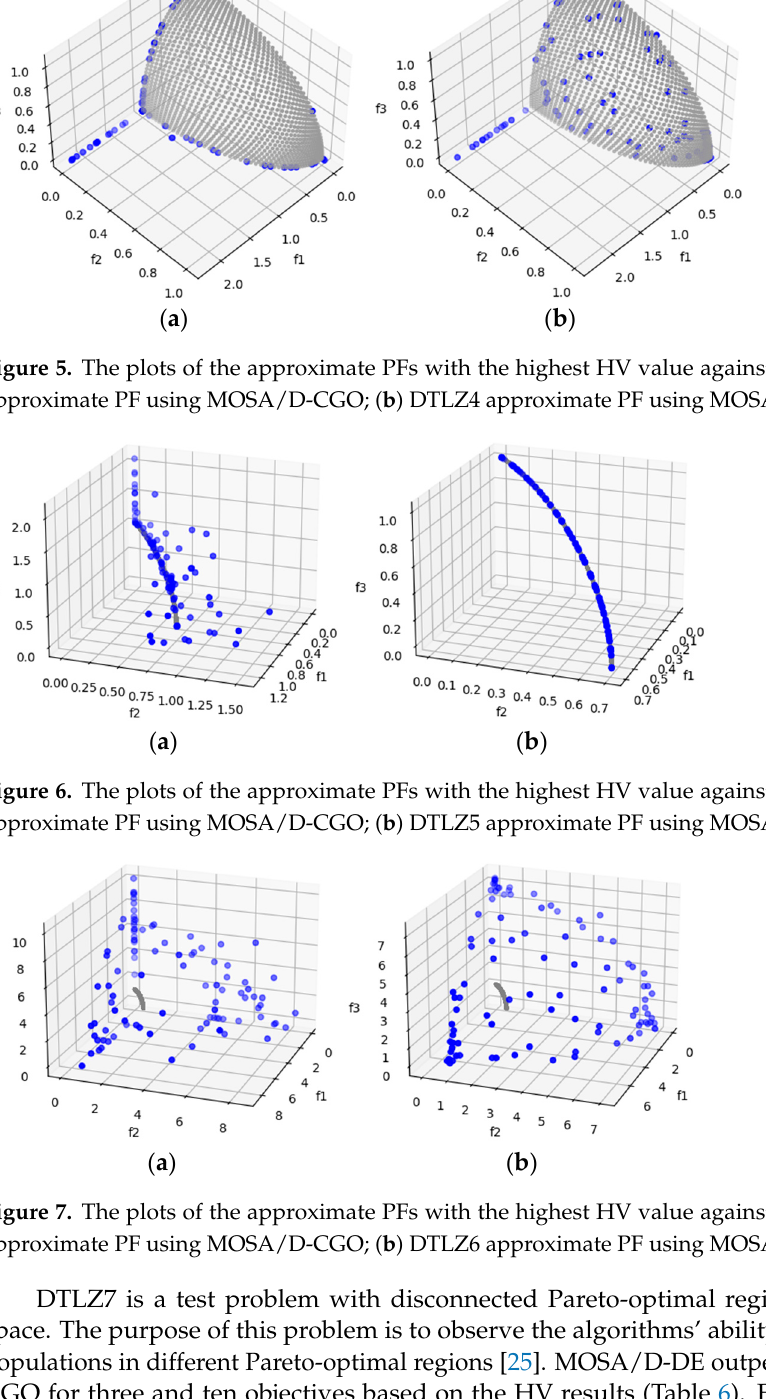
Figure 5. The plots of the approximate PFs with the highest HV value against real PF. ( a ) DTLZ4 approximate PF using MOSA/D-CGO; ( b ) DTLZ4 approximate PF using MOSA/D-DE.